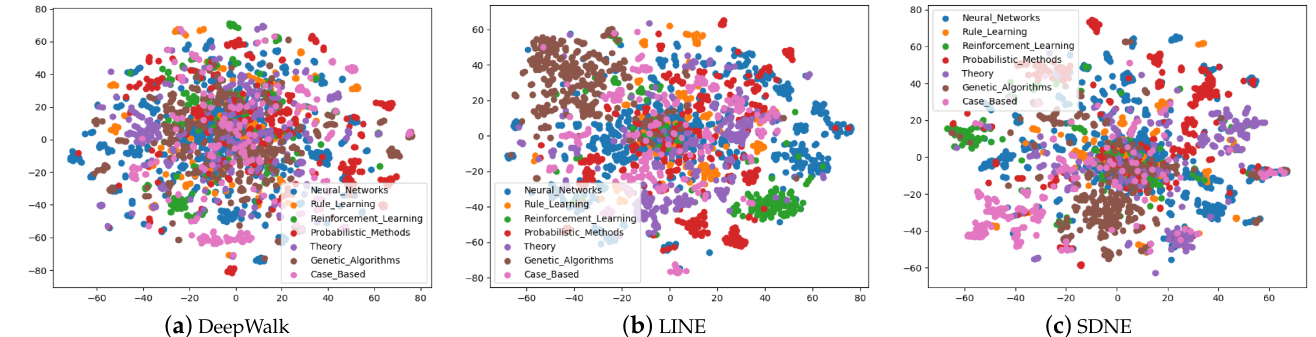
Figure 8. A comparison of the visualization results of the three methods for the Cora dataset. ( a ) The result of DeepWalk, ( b ) the result of LINE, and ( c ) the result of SDNE. Differently colored nodes represent different categories. The dataset contains seven categories (neural networks; rule learning; reinforcement learning; probability methods; theory; genetic algorithms; case-based).